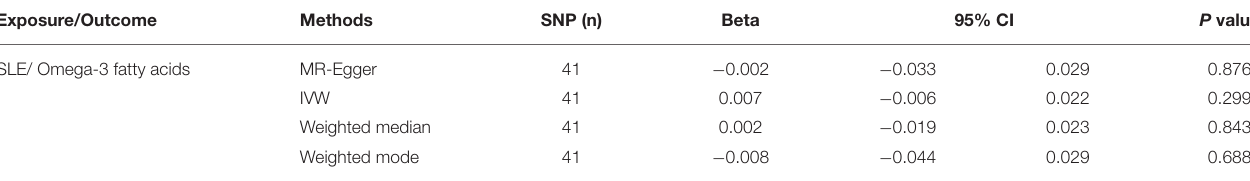
TABLE 3 | Causal effects of the risk of SLE on Omega-3.